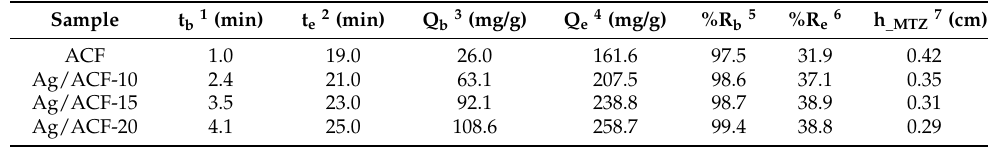
Figure 8. Breakthrough adsorption capacity (Q b ) and exhaustion adsorption capacity (Q e ) obtained from AA adsorption breakthrough curve ( a ) and relative adsorption capacity versus concentration of silver precursor ( b ). Table 3. Comparison of efficiency parameters for acetaldehyde adsorption.